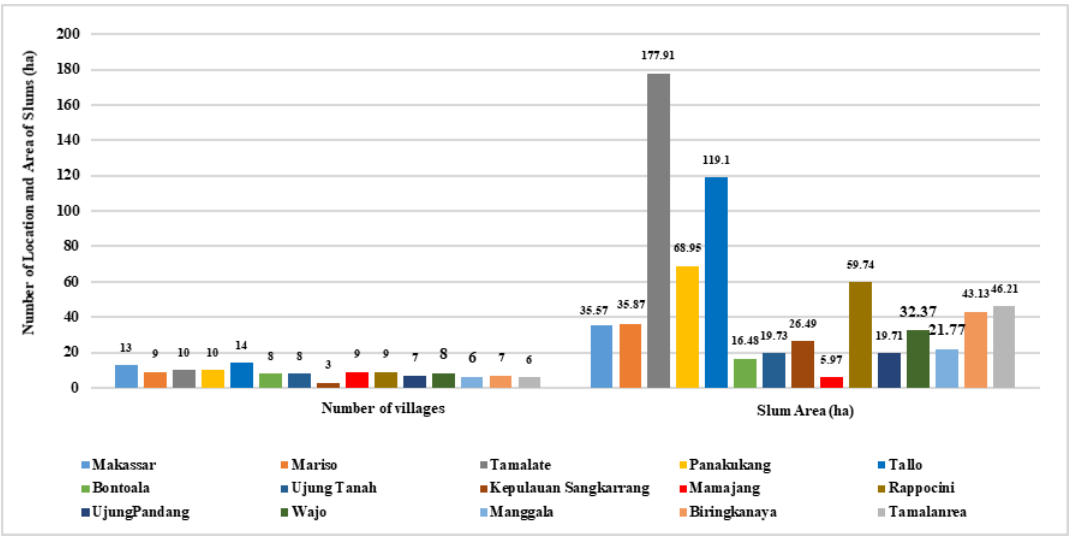
Figure 5. Distribution of Makassar City Slums, 2019.